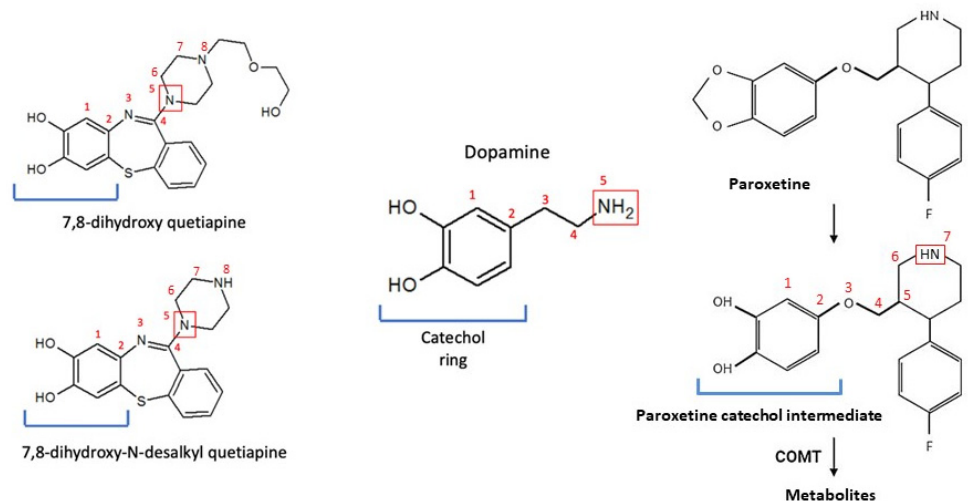
Figure 2. Comparison of catechol structures between 7,8-dihydroxy quetiapine, 7,8-dihydroxy-N-desalkyl quetiapine, dopamine, and paroxetine catechol intermediate. Figure created with ChemSketch software(ACD/Labs, Toronto, ON, Canada).